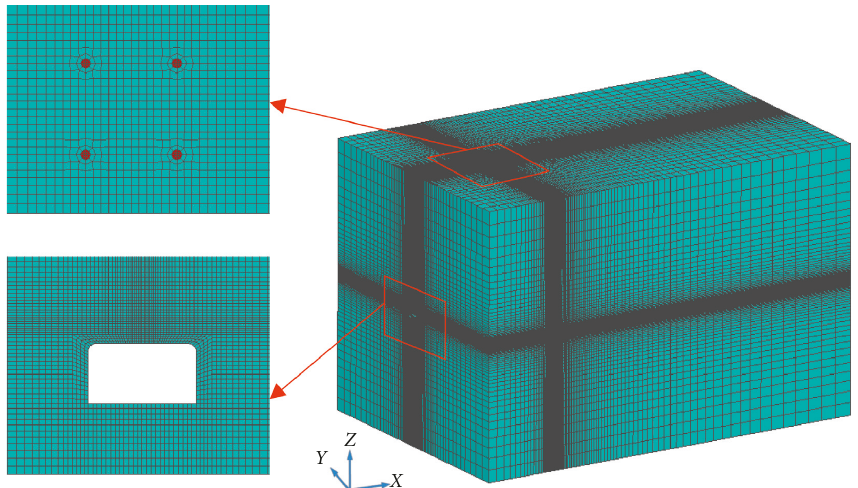
Figure 11: Numerical model used for modelling of blast-induced vibration.